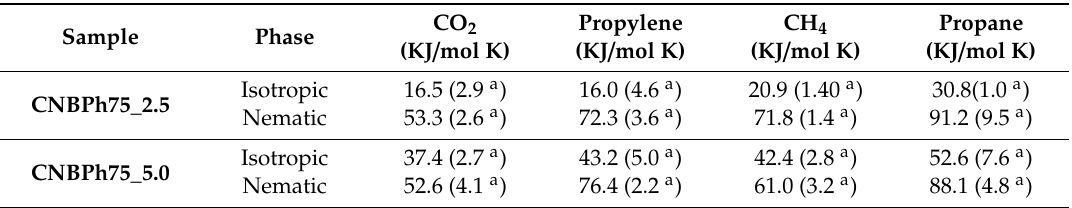
Figure 15. Arrhenius plot of permeabilities for gases in the CNBPh75_2.5 membrane (2.5% crosslinker) in the nematic and isotropic phases. Table 2. Activation energies ( E A ) for permeation in the nematic mesophase and the isotropic phase